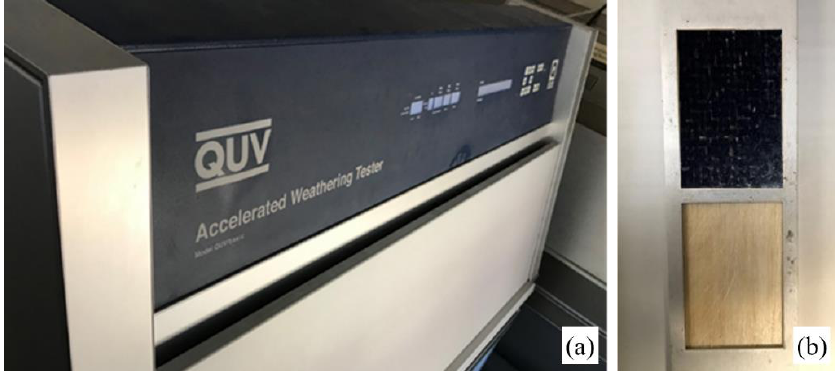
Figure 4. ( a ) QUV-accelerated weathering tester; ( b ) specimen rack placed into the aging